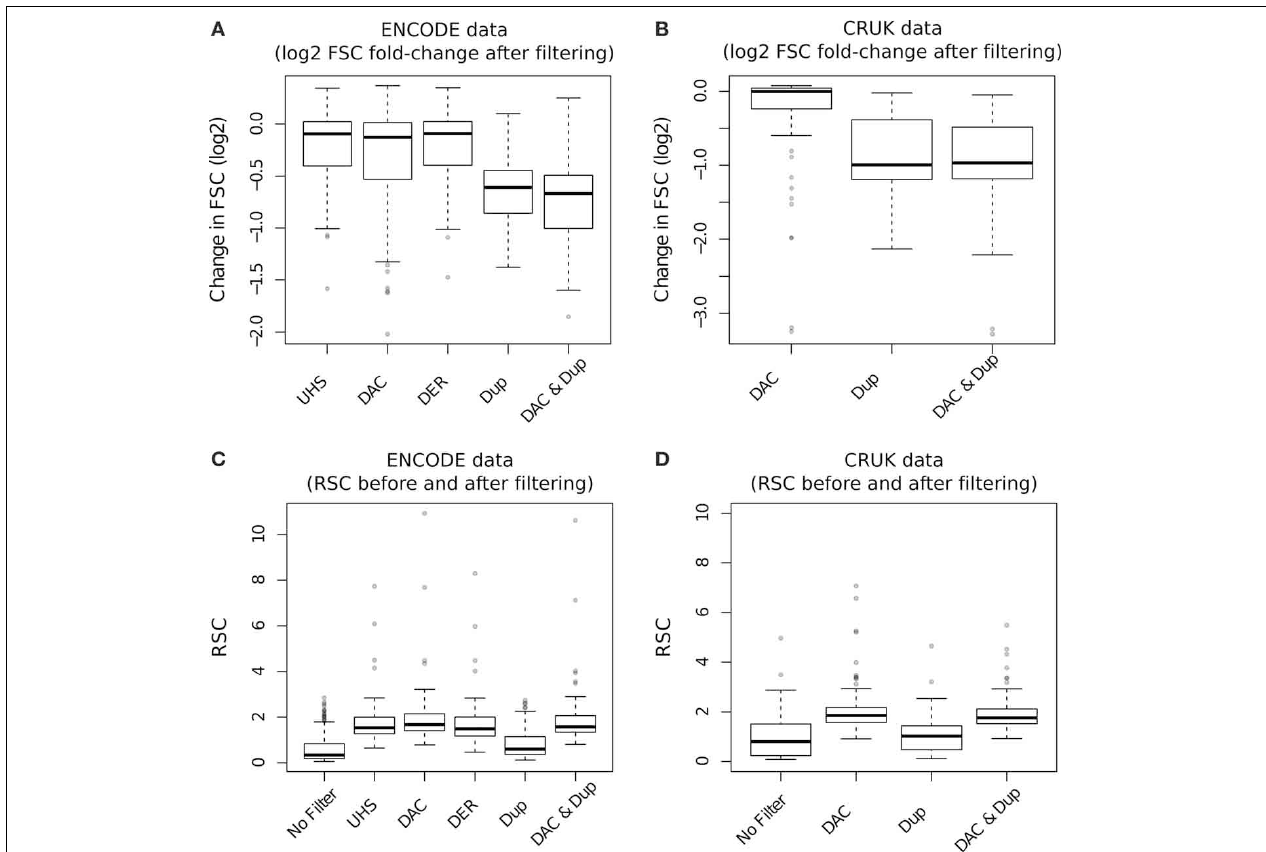
FIGURE 8 | (A,B) Boxplots of the RSC scores for TF datasets from the ENCODE/SYDH (A) and from CRUK (B) sets after differing filtering steps. For the CRUK set only the DAC consensus set was used to evaluate the effect of blacklisting given its observed greater enrichment for artifact signal over the DER/UHS sets within ENCODE data. (C,D) Boxplots of